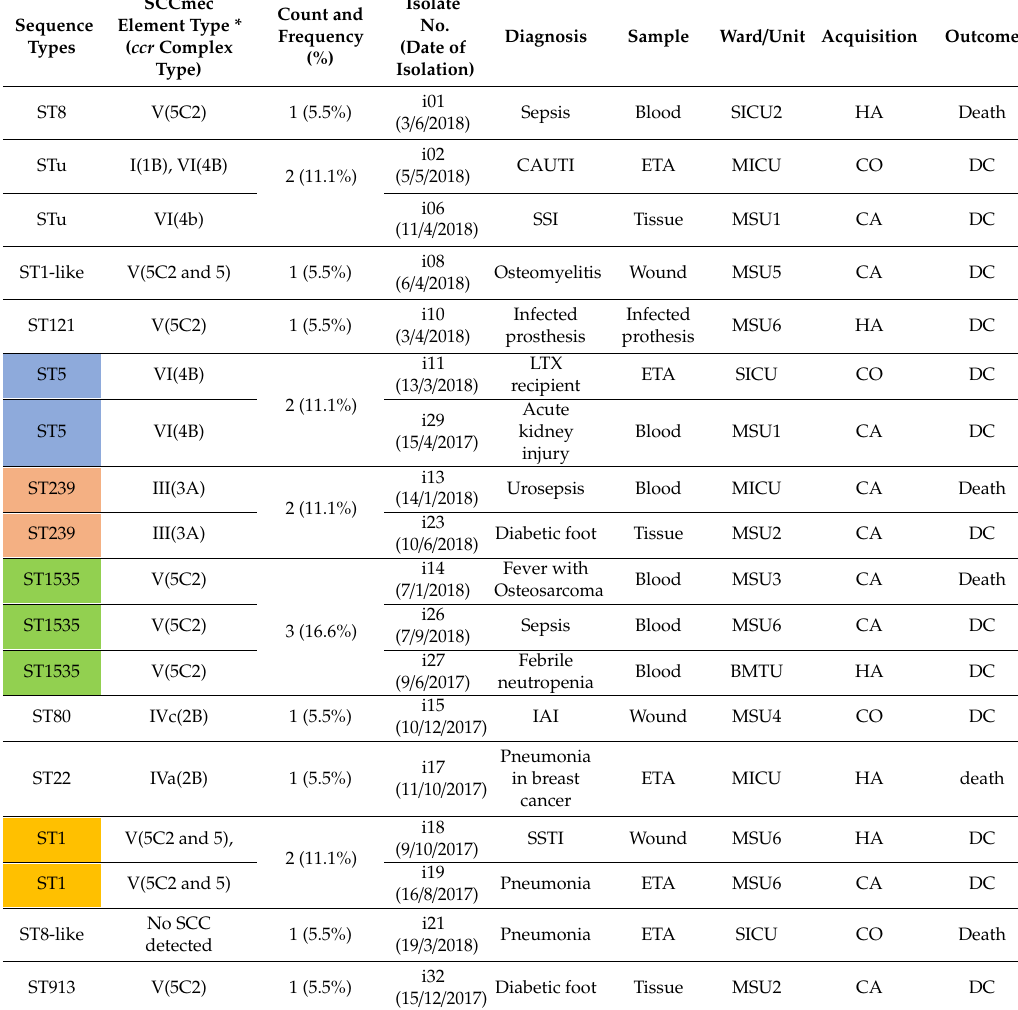
Table 1. Clinical, epidemiological and molecular characteristics of methicillin-resistant S. aureus (MRSA) isolates ( n =